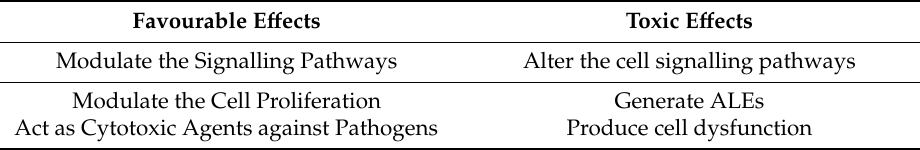
Table 2. The biological e ff ects of Reactive carbonyl species (RCSs) derived from lipids